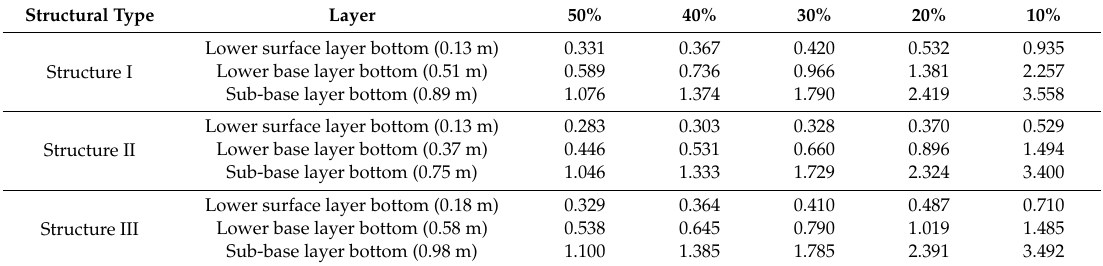
Table 6. Threshold distance of each layer (unit: m).